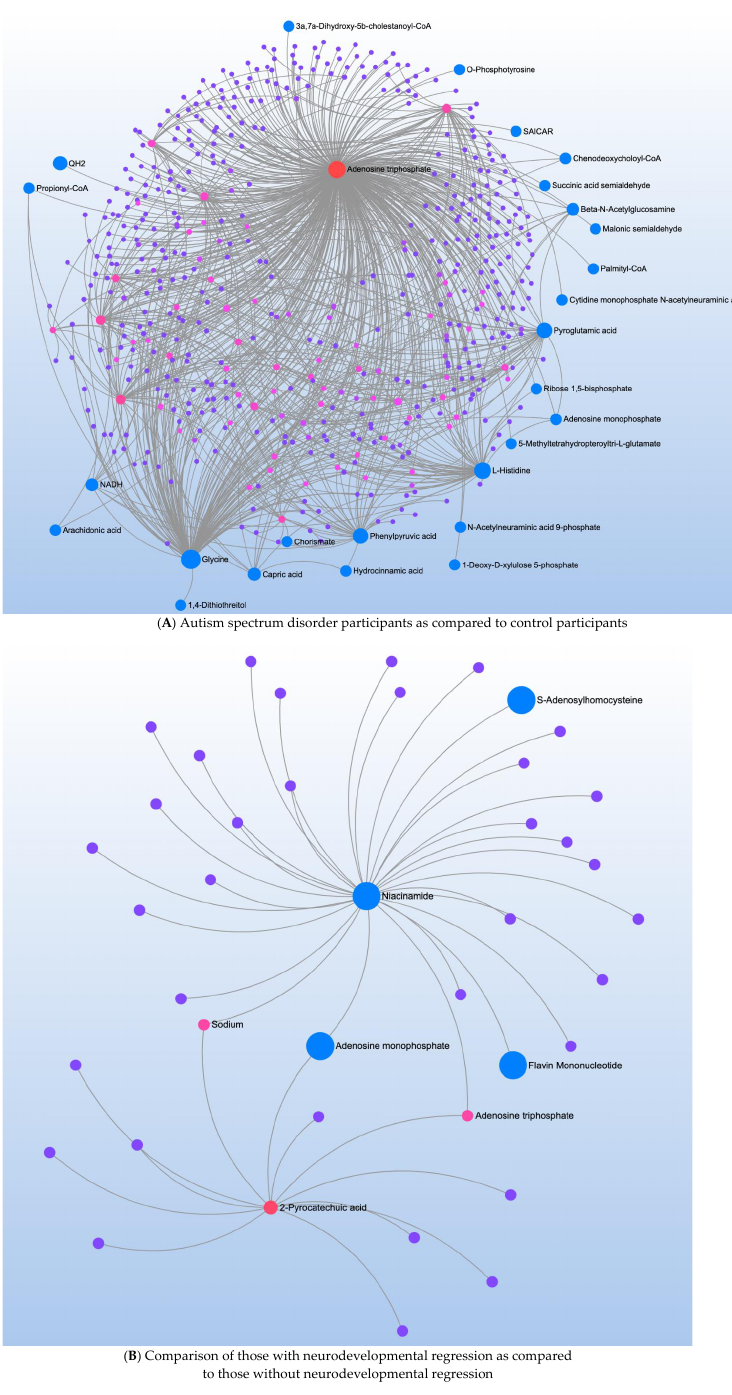
Figure 1. Metabolite-metabolite interaction network for significant metabolites that differentiate participants with ( A ) autism spectrum disorder (ASD) from typically developing controls and ( B ) those with ASD with and without neurodevelopmental regression (NDR). Size of the node indicates importance in the network. The network highlights that importance of adenosine triphosphate in differentiating those with and without ASD and those with ASD but with and without NDR. The importance of nicotinamide metabolism in differentiating those with and without NDR is also highlighted by the interaction analysis.